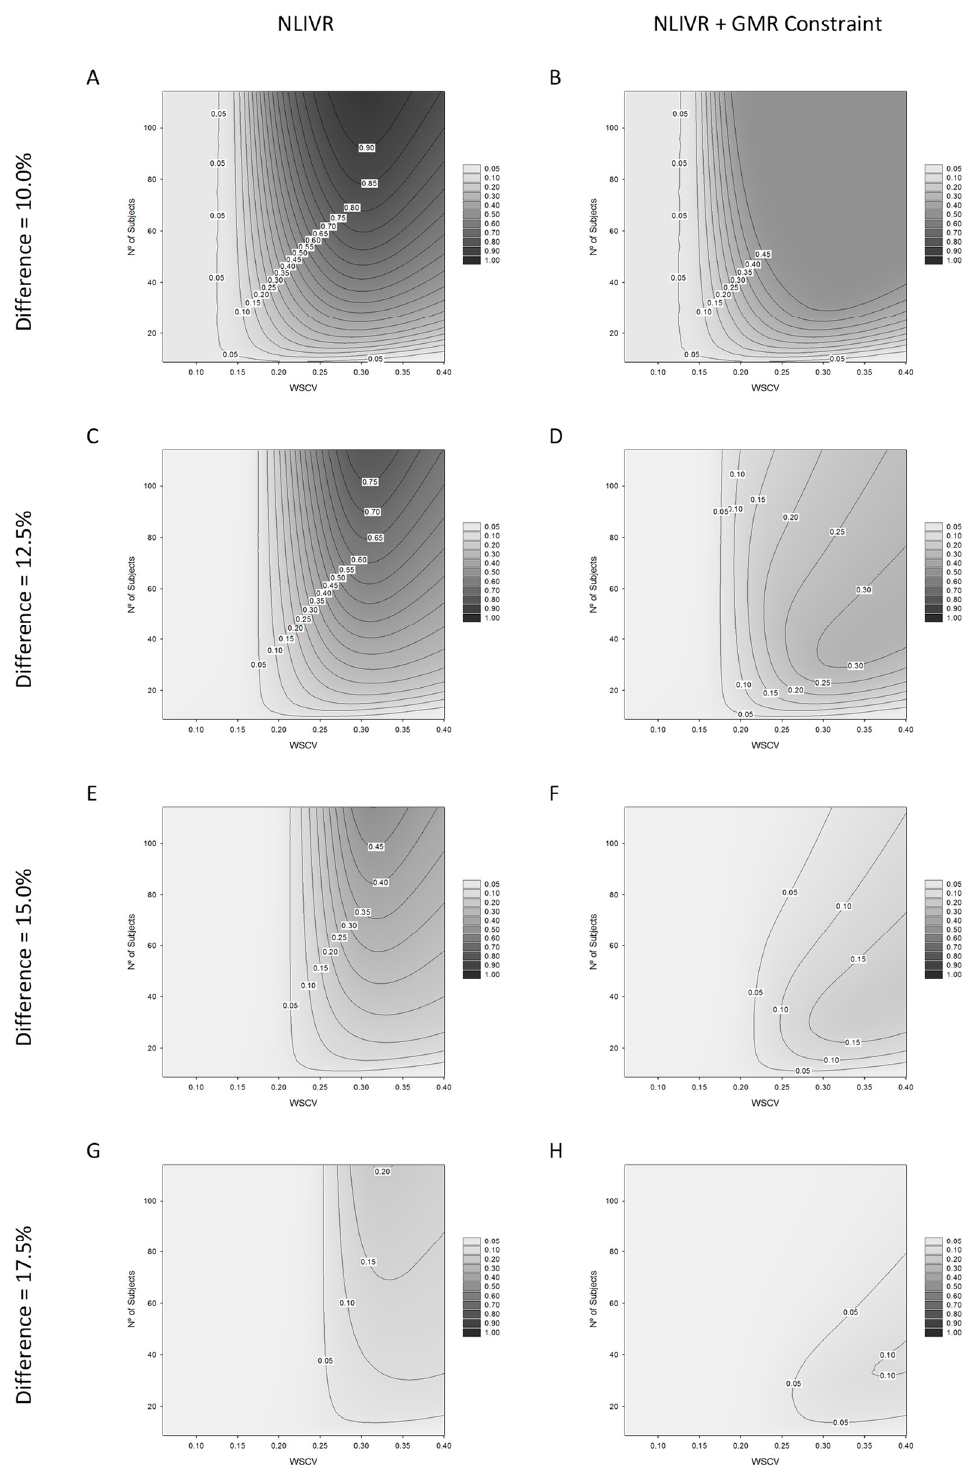
Figure 2. Power analysis for the proposed NLIVR conditions with and without a GMR constraint assuming increasing nominal differences between the test and reference formulations, for different WSCV and number of subjects. Legend represents the probability of concluding BE. ( A , C , E , G ) are related to the NLIVR conditions and ( B , D , F , H ) for the NLIVR with a GMR constraint, for each of the corresponding nominal differences from 10% to 17.5%.